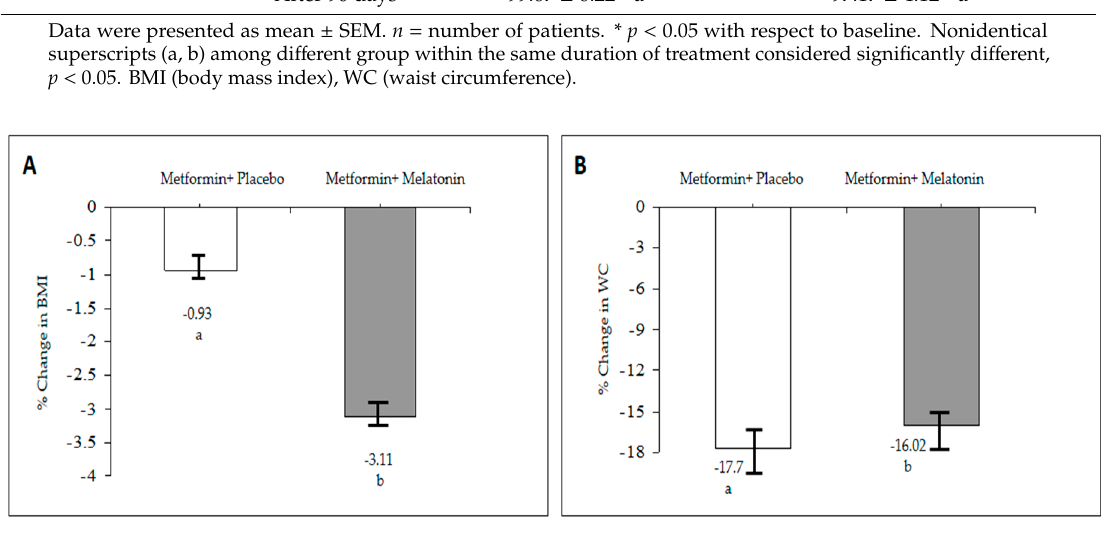
Figure 6. Comparison between the effects of metformin-placebo and metformin-melatonin on BMI (A) and WC(B) measurements in MEBS patients after 90 days of treatment; (a, b) significantly different ( p < 0.05); BMI (body mass index), WC (waist circumference).